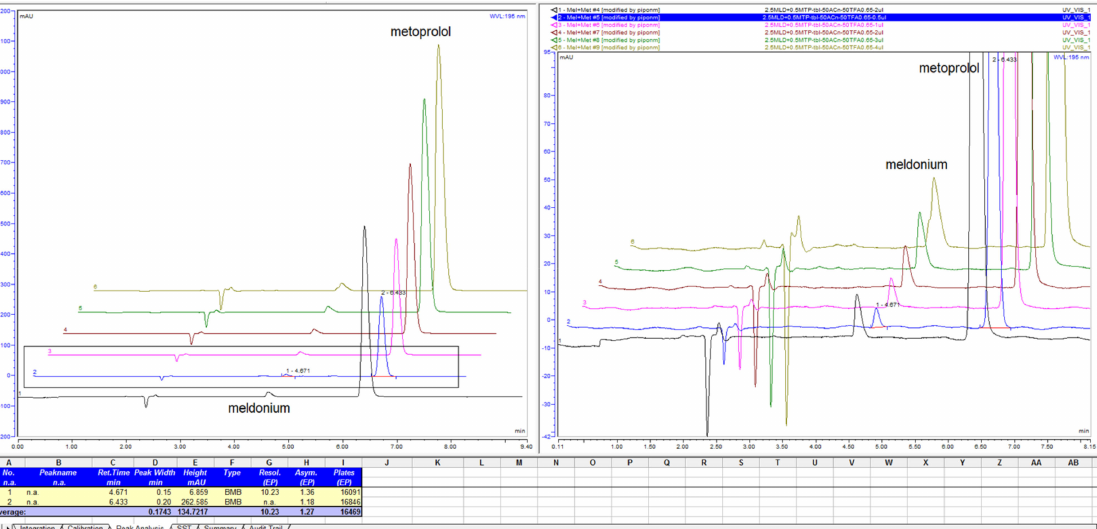
Figure 23. Dionex-full scale overlaid and expanded zoomed Y-axis of overlaid chromatograms for linearity of method with Waters Spherisorb CNRP-250 × 4.6 mm and 50% ACN and 50% diluted TFA at 195 nm, with system suitability parameters in table below.